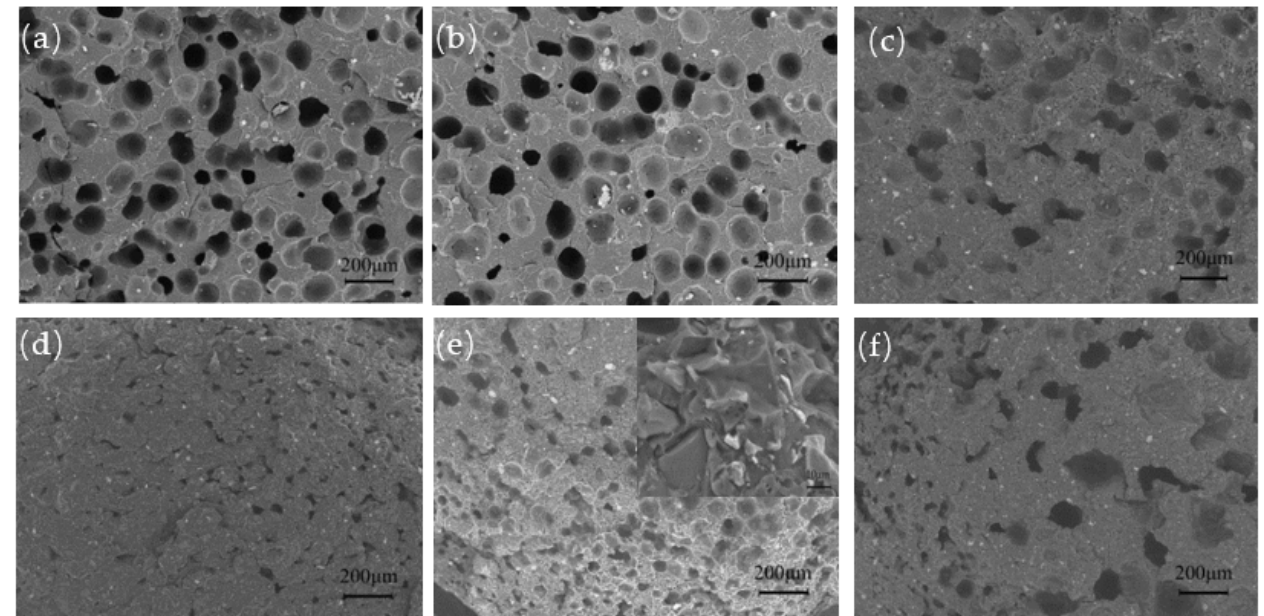
Figure 2. SEM images of the foamed E-PP/BC composites with BC content of ( a ) 0 wt.%, ( b ) 5 wt.%, ( c )20 wt.%, ( d ) 30 wt.%, ( e ) 40 wt.%, and ( f ) 50 wt.%.